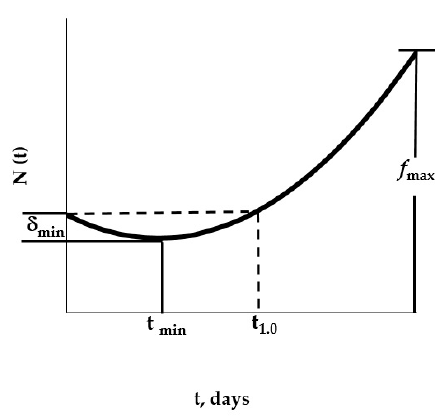
Figure 6. Characteristic values ( δ min , t min , t 1.0 , and f max ) for the respective master curves.